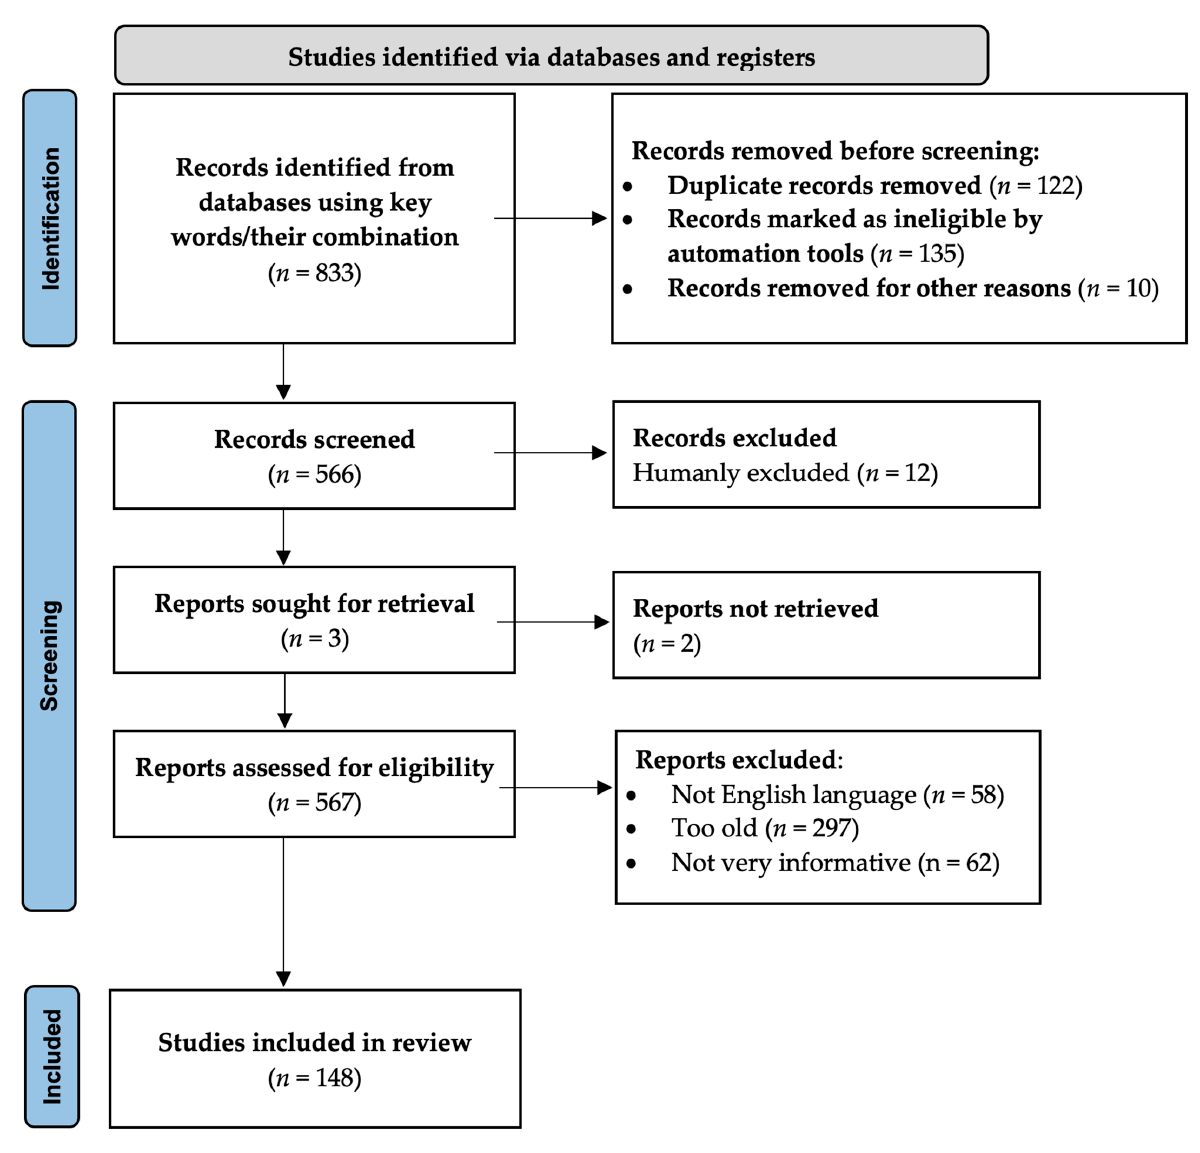
Figure 1. Flow chart presenting the steps of published data selection for being included in the present paper.